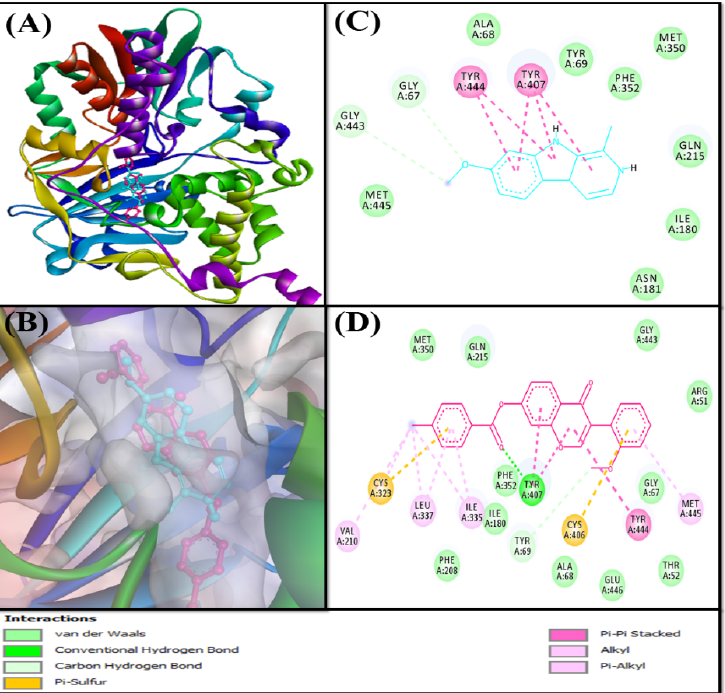
Figure 2. Interaction of target protein, BChE with F0850-4777 and their respective control ligands. ( A ) Position of F0850-4777 and Tacrine in BChE. ( B ) Interactions between BChE and Tacrine ( C ). Superimposed image of F0850-4777 and Tacrine in BChE. ( D ) Interactions between BChE and F0850- 4777.